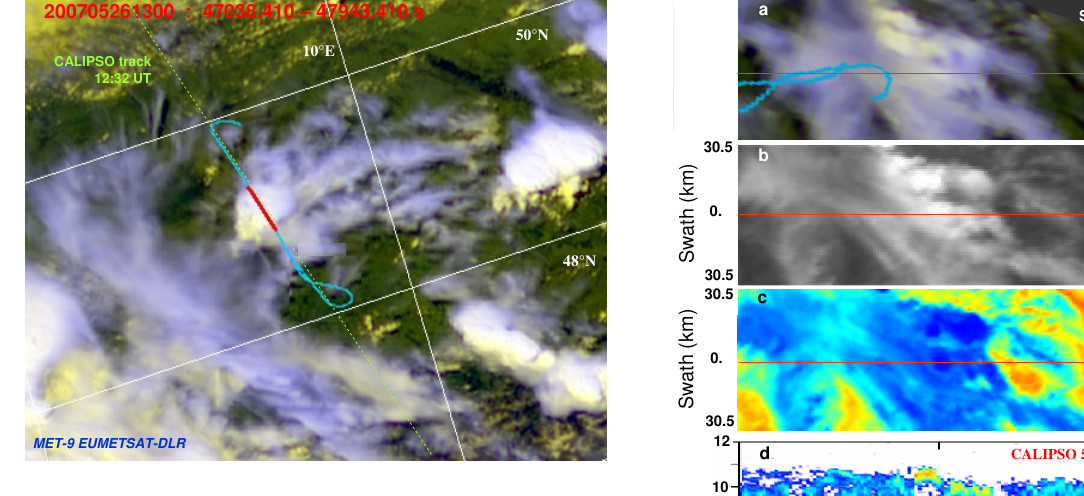
Fig. 3. False color composites of MET-9/SEVIRI observations from 26 May 2007 at 13:00UT. The Falcon trajectory (between 12:45 and 13:15UT) is superimposed (blue line). The flight segment in red color indicates the penetration in the convective cloud. The CALIPSO track (at 12:32UT) is also displayed.